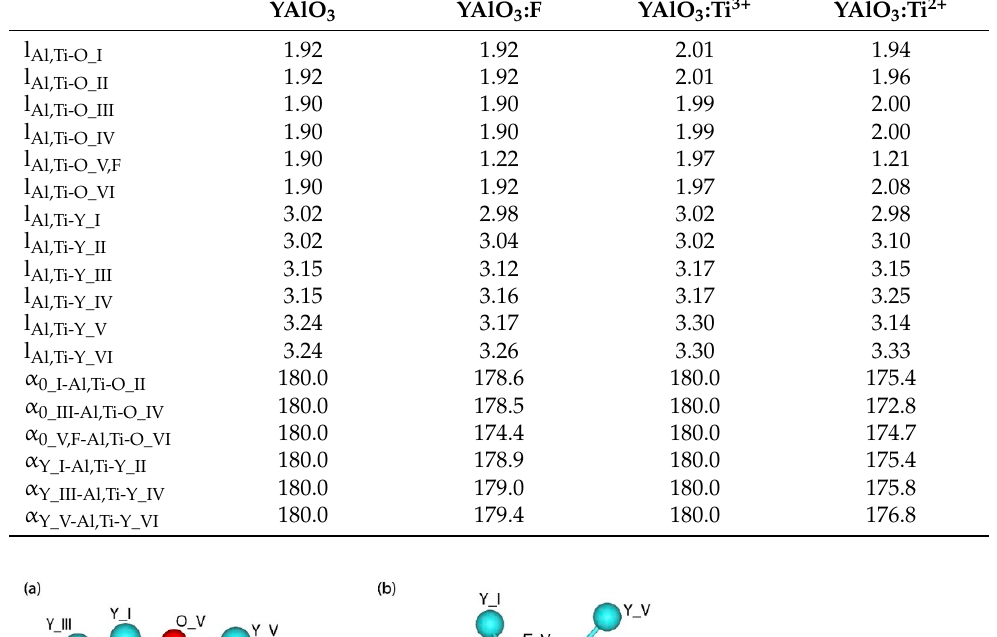
Table 3. Atomic structure of pristine and Ti-doped YAlO 3 crystals in orthorhombically distorted perovskite structure. Bond lengths l are given in Å and bond angles α are in degrees. For atomic notations please see Figure 2.